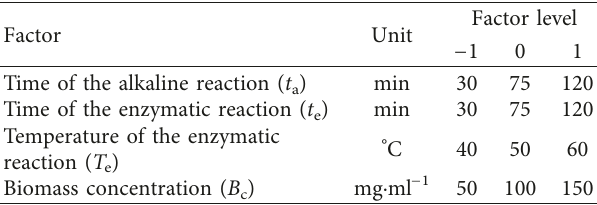
Table 1: Levels of the factors in the experimental design according to the face-centered